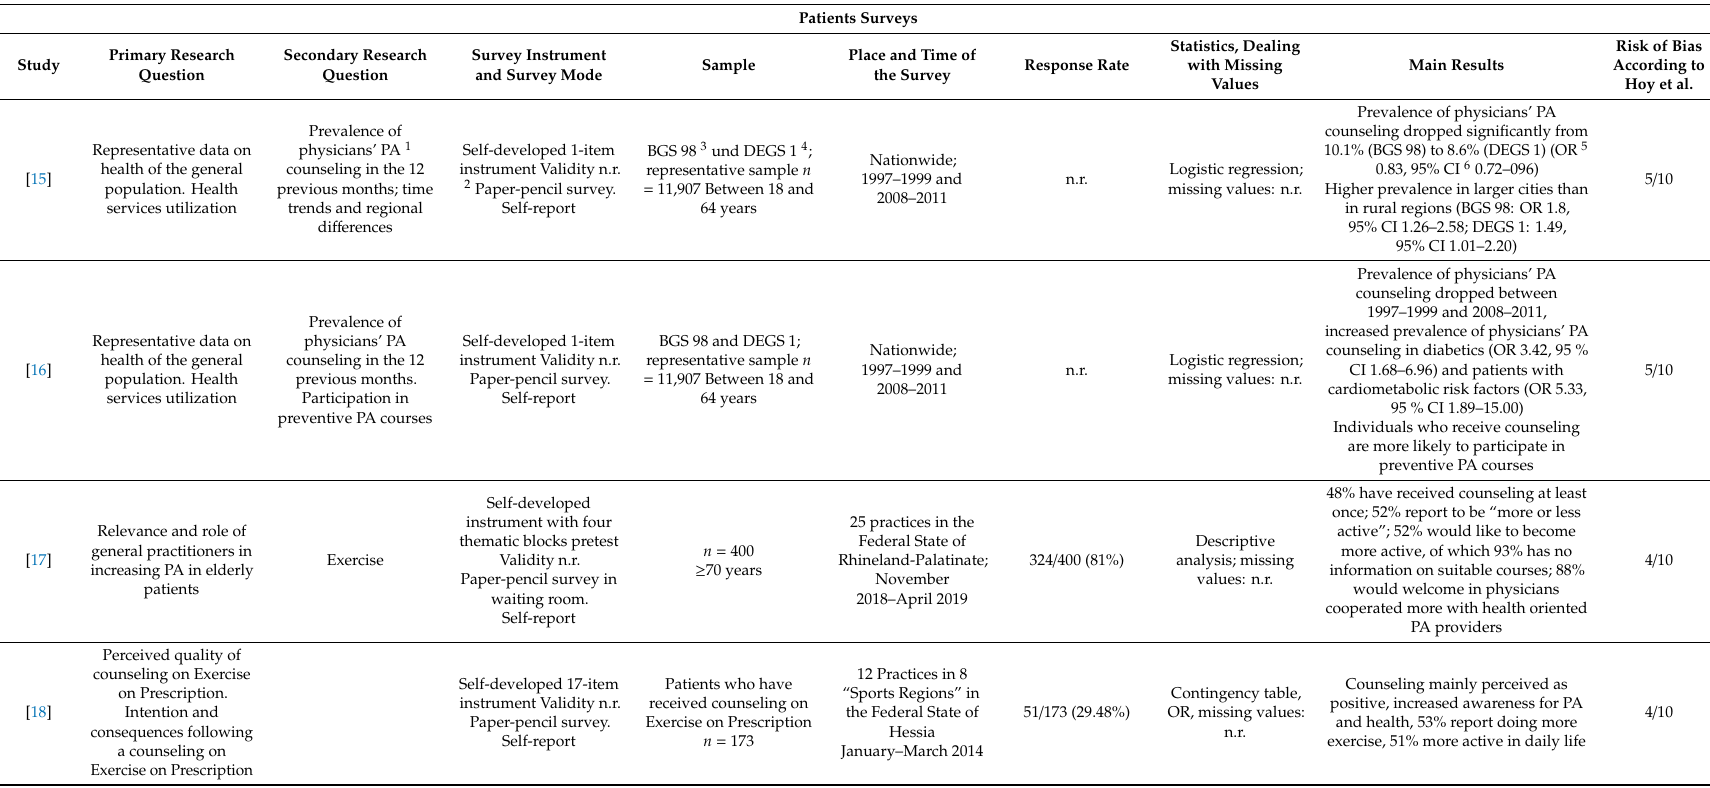
Table 1. Quantitative studies.